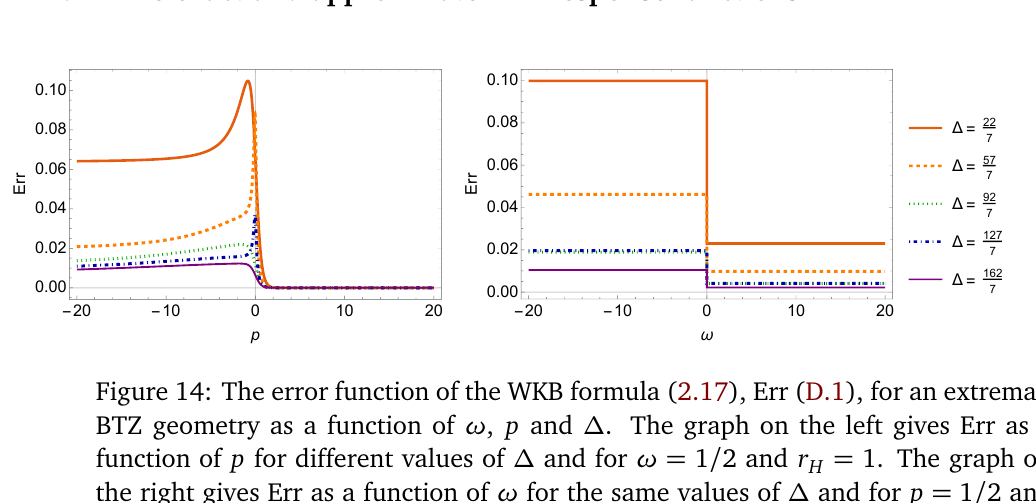
= 1. The graph on H